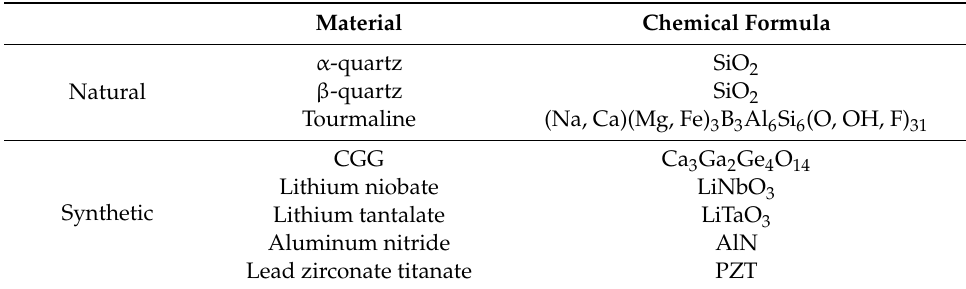
Table 1. Selected natural and synthetic piezoelectric